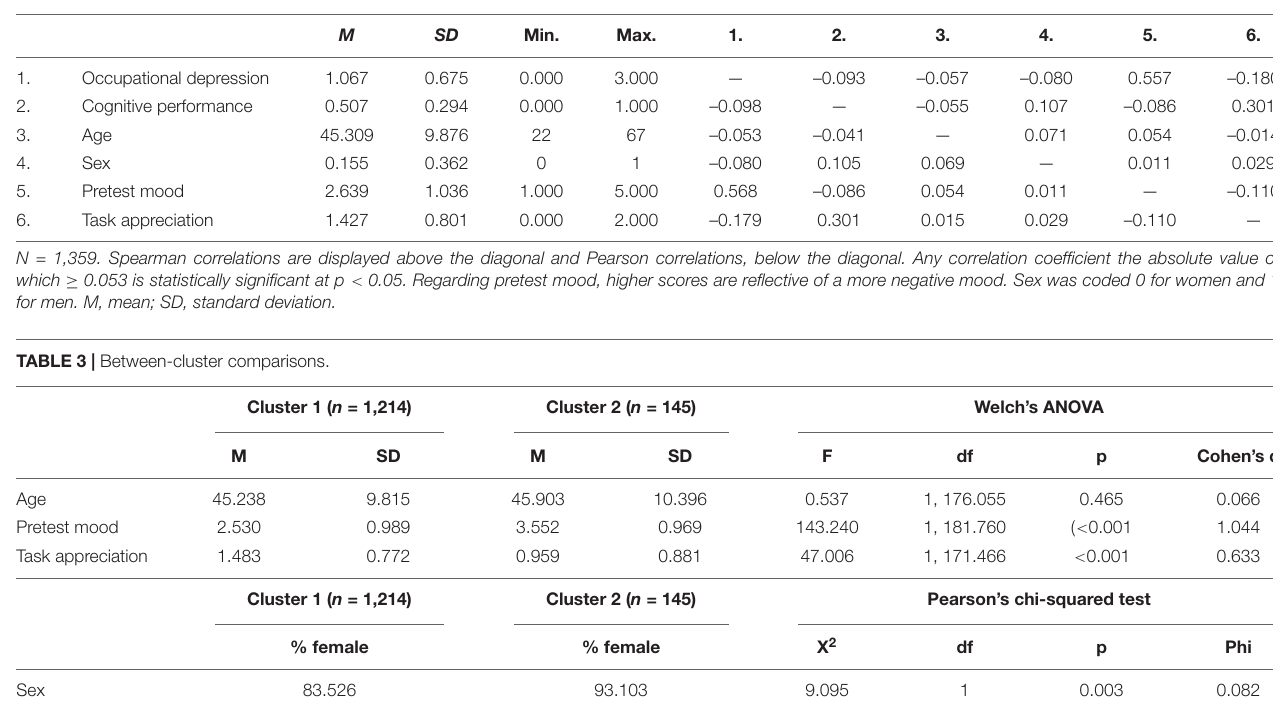
TABLE 2 | Spearman and Pearson correlations among the main study variables.